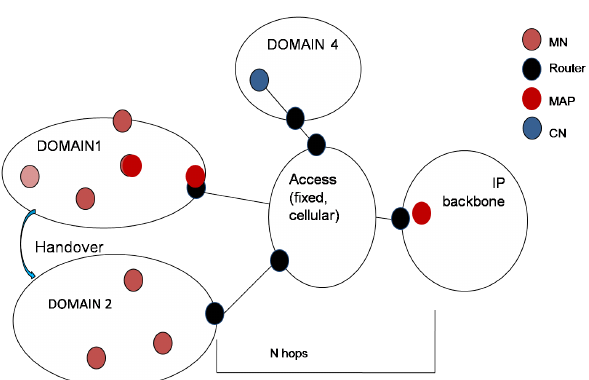
Figure 1. High-level representation of mobility management main entities, the MN, the CN, and the MAP. The MAP is often co-located with different devices, including end-user